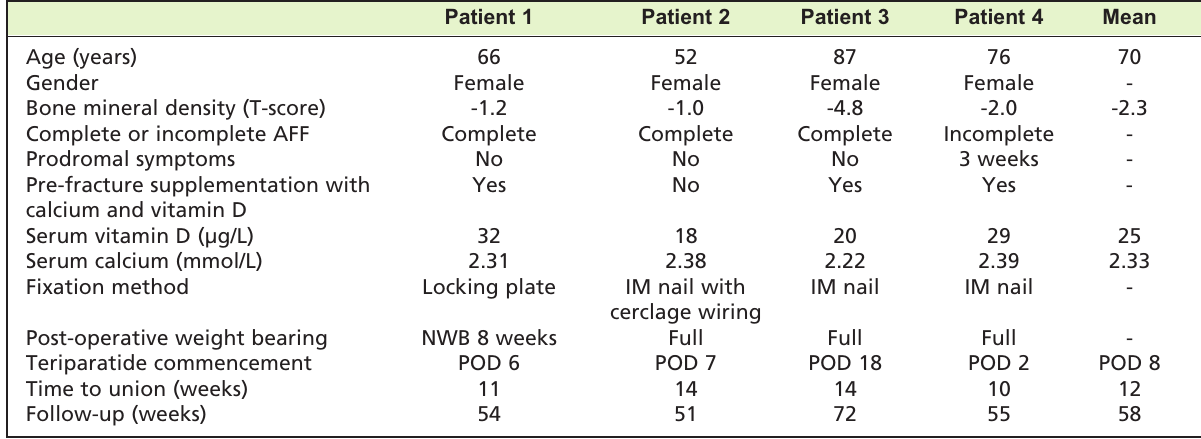
Patient Table I: